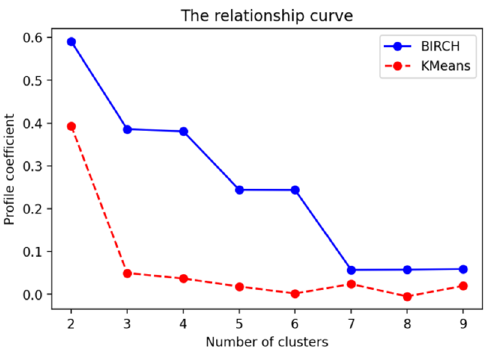
Figure 7. Contour coefficients corresponding to different clustering coefficients in the two clustering algorithms.